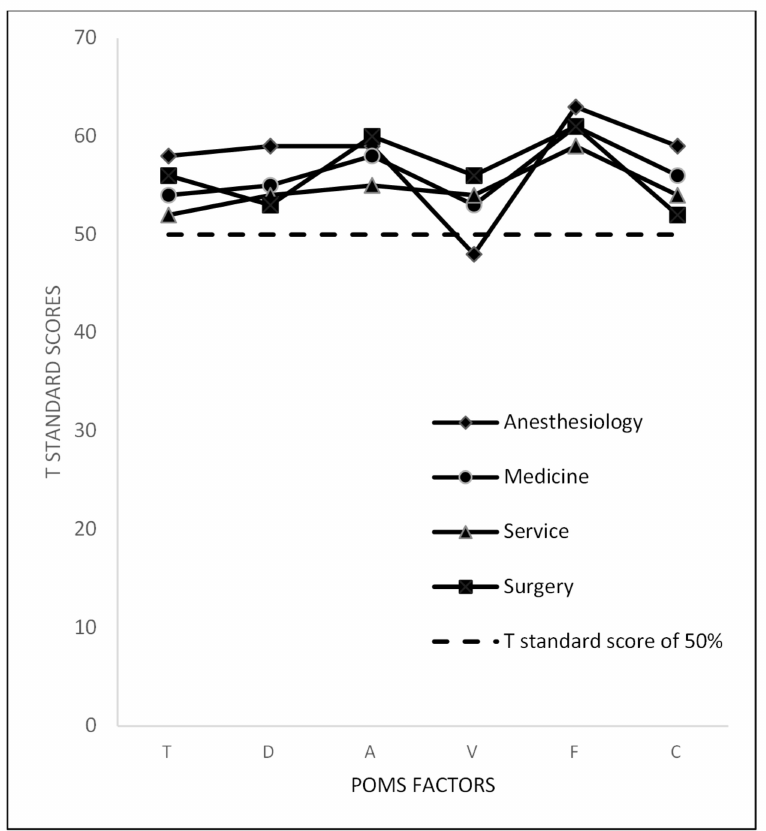
Figure 1. Mean POMS scores in residents, stratified according to specialty